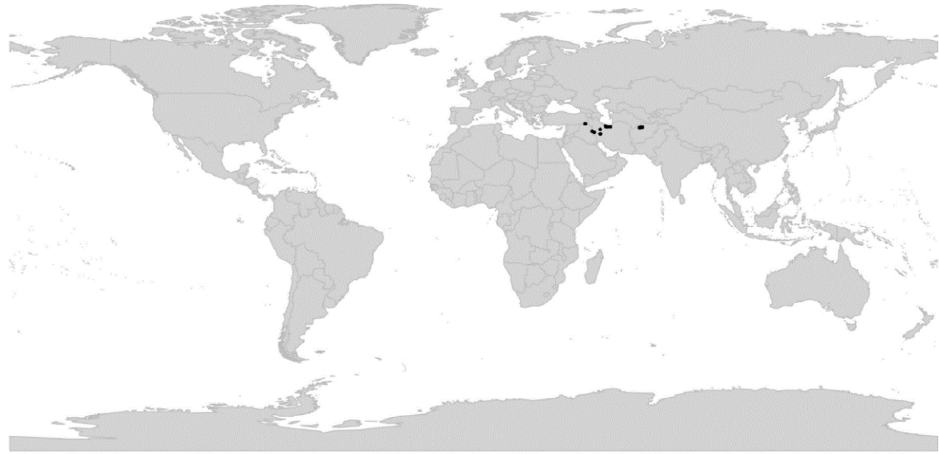
Figure 30. Global distribution of Viola sect. Spathulidium .